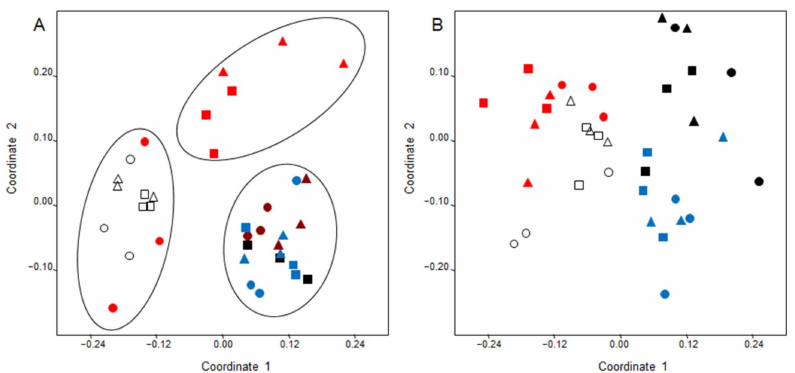
Figure 4. MDS ordination plots of bacterial 16S rDNA ( A ; stress = 0.218) and fungal 18S rDNA ( B ; stress = 0.282). Symbols: circle = D0 treatment; triangle = D50 treatment; square = D100 treatment. Colours: white = time t 0 ; red = time t 1 ; blue = time t 2 ; black = time t 3 .